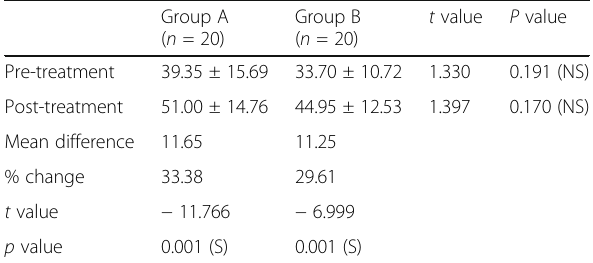
Table 7 Comparison of mean value of left side bending within and between